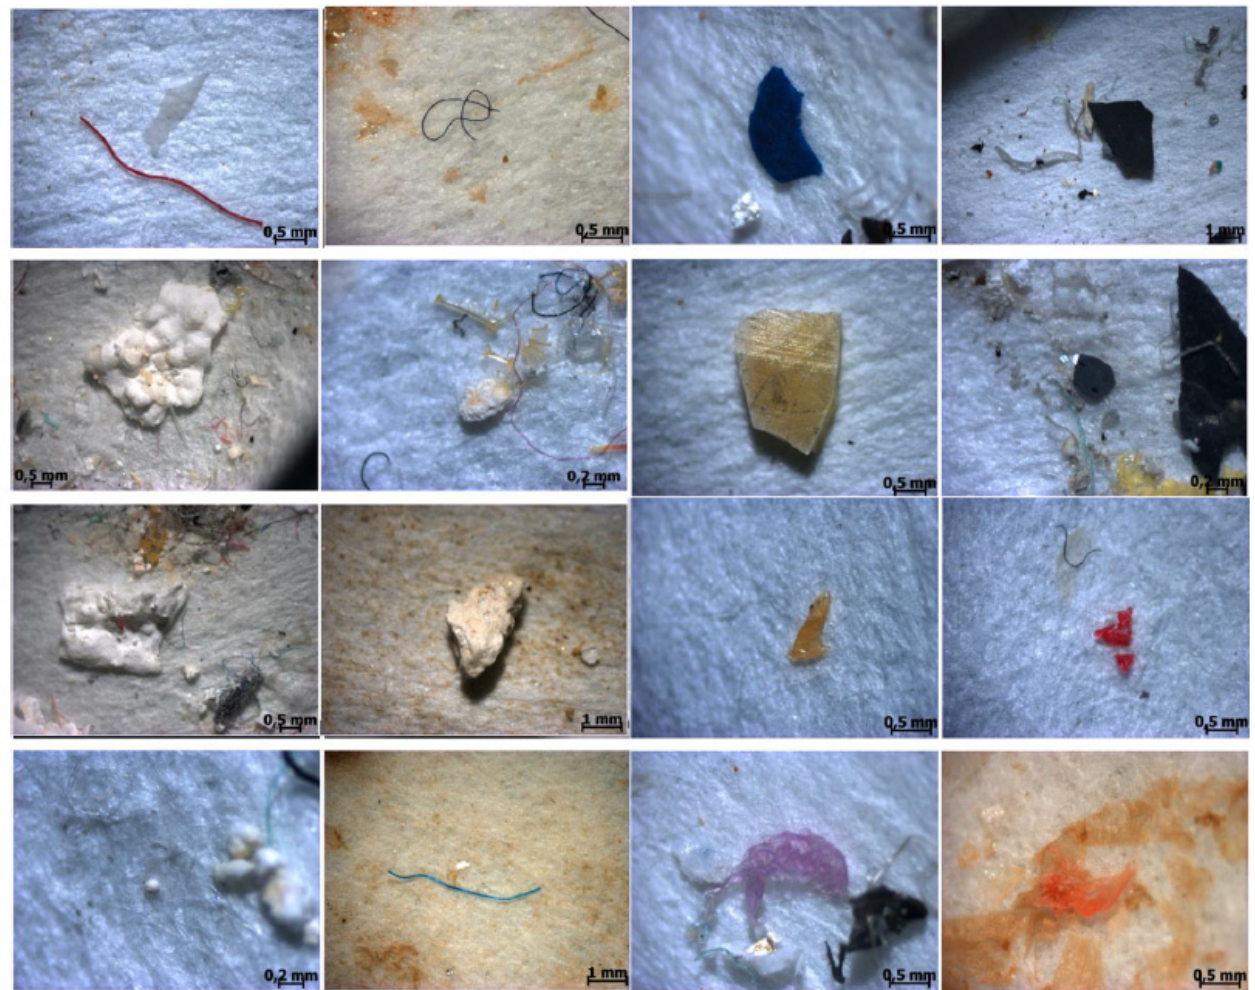
Figure 2. Images of microplastics found in River’s water in the studied area.